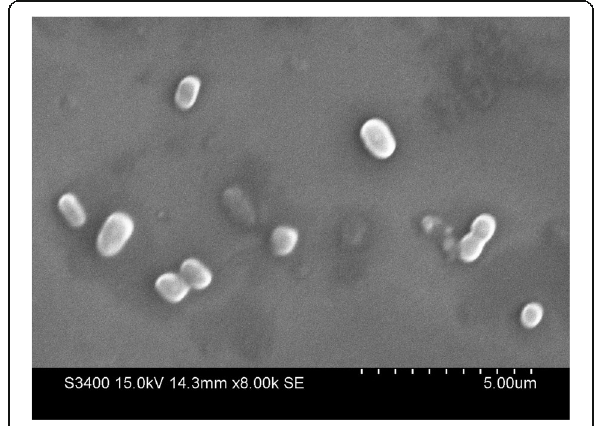
Fig. 1 Scanning electron micrograph of strain J. lividum ERGS5:01 grown at ABM agar plates for 48 h at 10 ° C. for 15 days. Bar, 5 μ